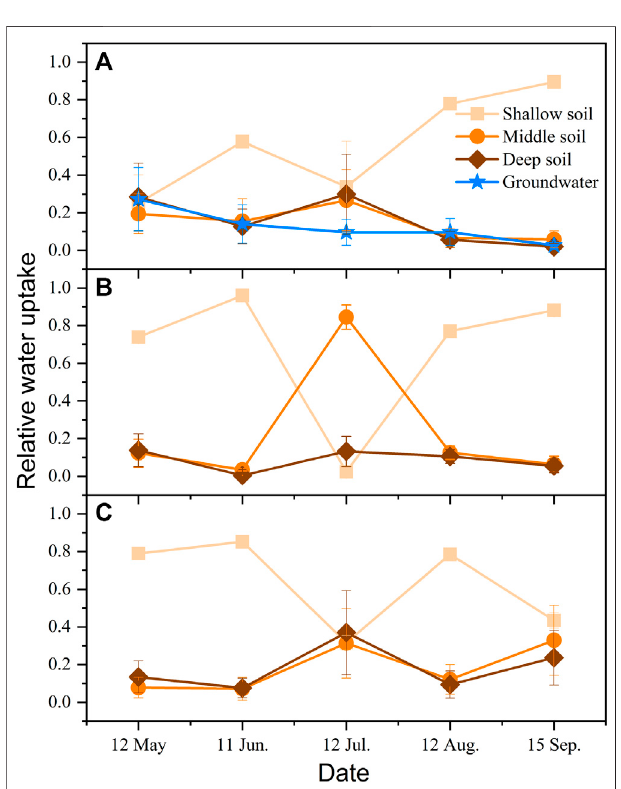
FIGURE9| Relative wateruptakeof Artemisia ordosica (Ao)at positions with different dune geomorphology. (A) Windward, (B) top of the dune, and (C)